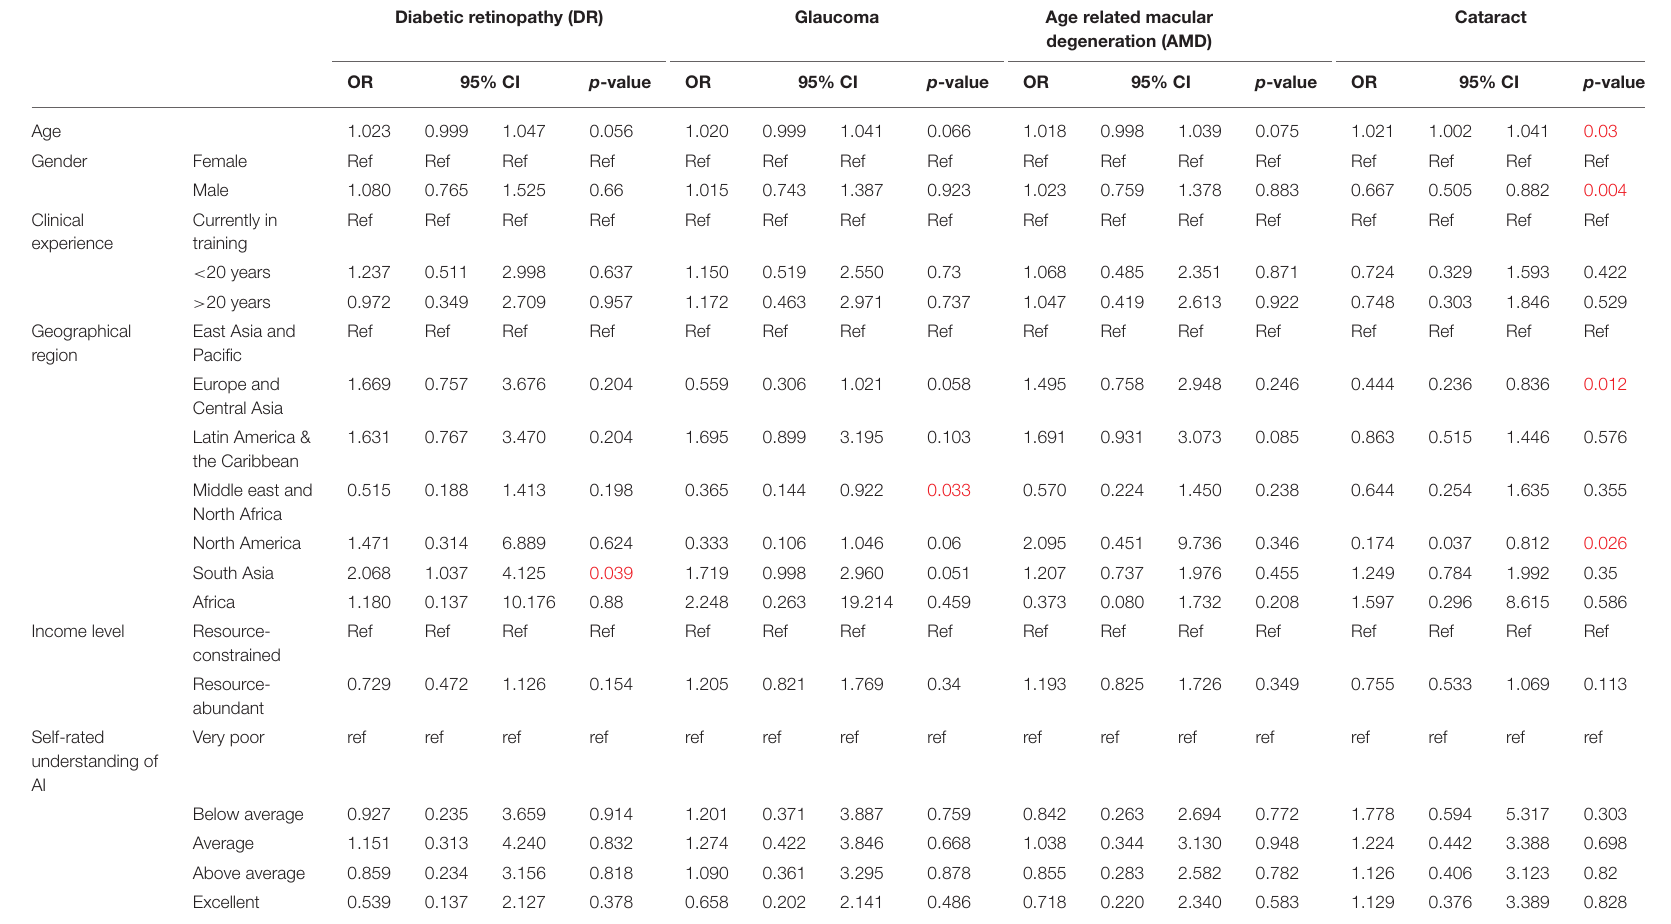
TABLE 3B | Organizational willingness to adopt applications of AI in Screening for eye